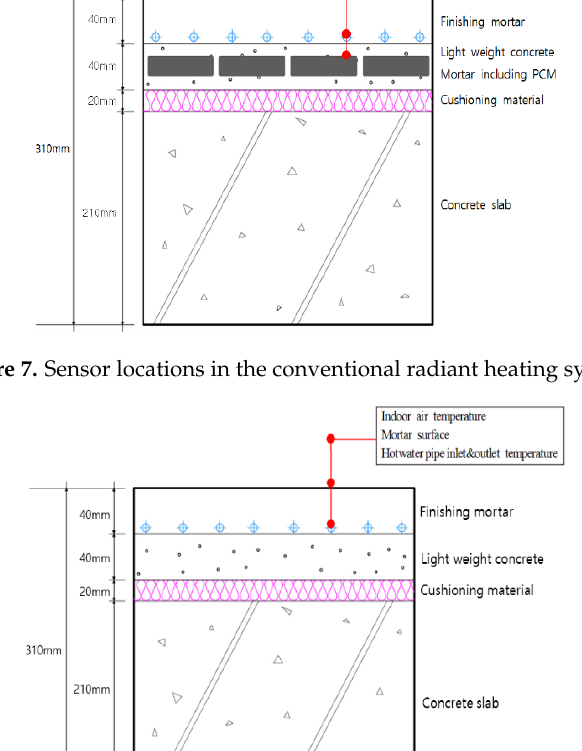
Figure 7. Sensor locations in the conventional radiant heating system.